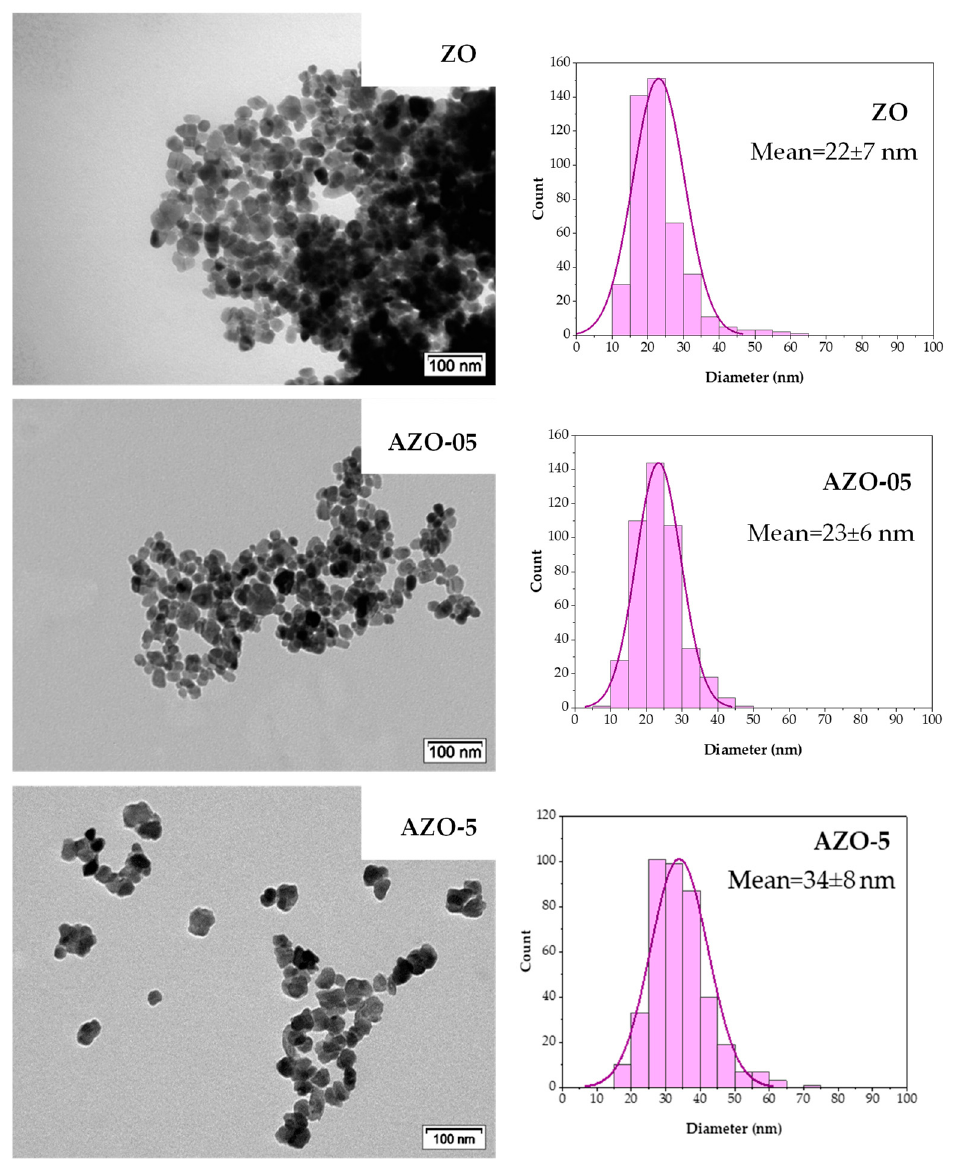
Figure 2. TEM micrographs of the ZO, AZO-05 and AZO-5 as-synthesized materials supported with the corresponding particle size histograms.